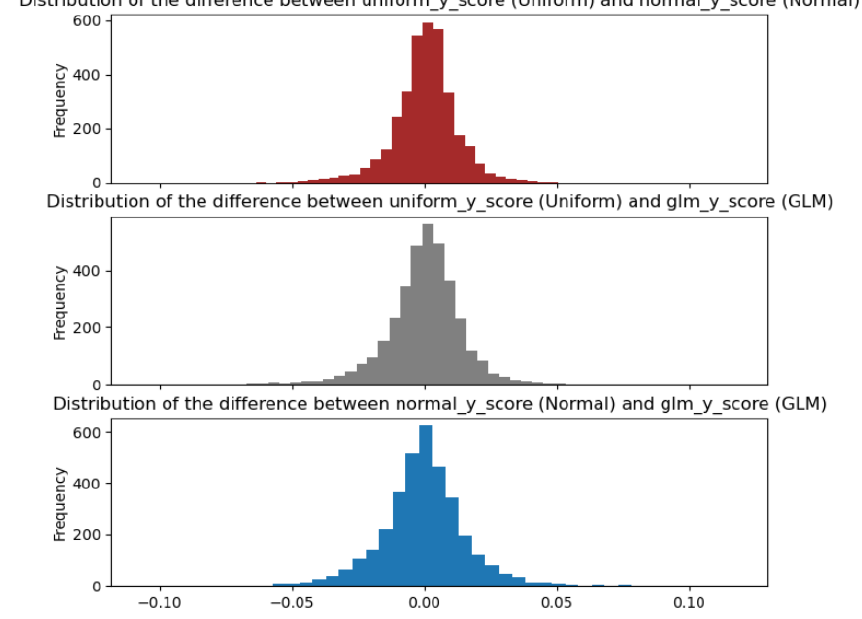
Figure 15. Differences in the distributions in the y-score for the Bayesian using uniform, normal, and built-in GLM priors.